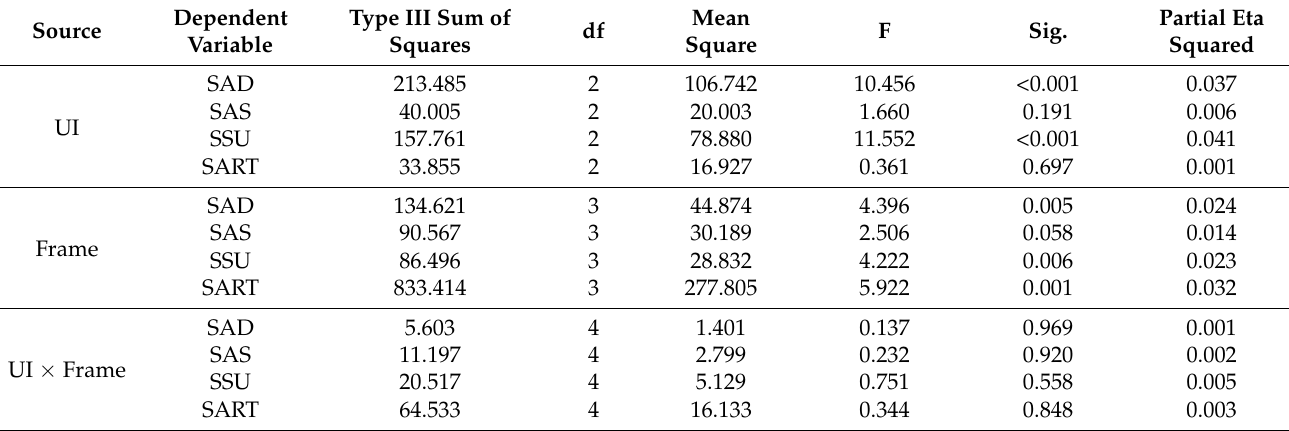
Table 6. Muti-way-ANOVA-analysis results of each dimension and the total score of